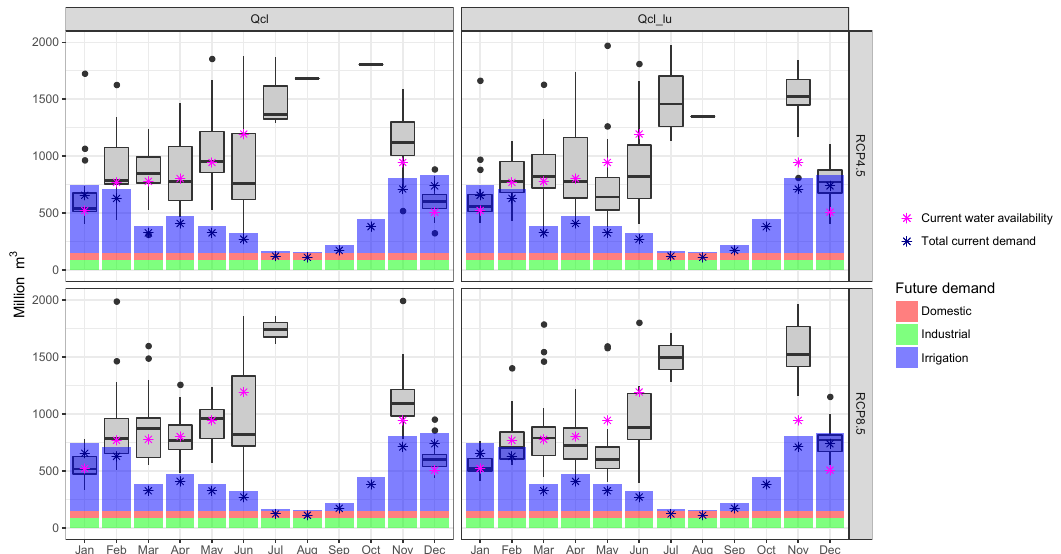
Figure 14. Bars showing future projections of monthly surface water demand for irrigation, domestic and industrial usage, during the period 2030–2035, for the Upper Ganges basin. Box plots indicate monthly flow volumes calculated by JULES under different GCM forcings for the same period. The demand data are based on figures presented in the studies by Sapkota et al. (2013) and Amarasinghe et al. (2007), as discussed